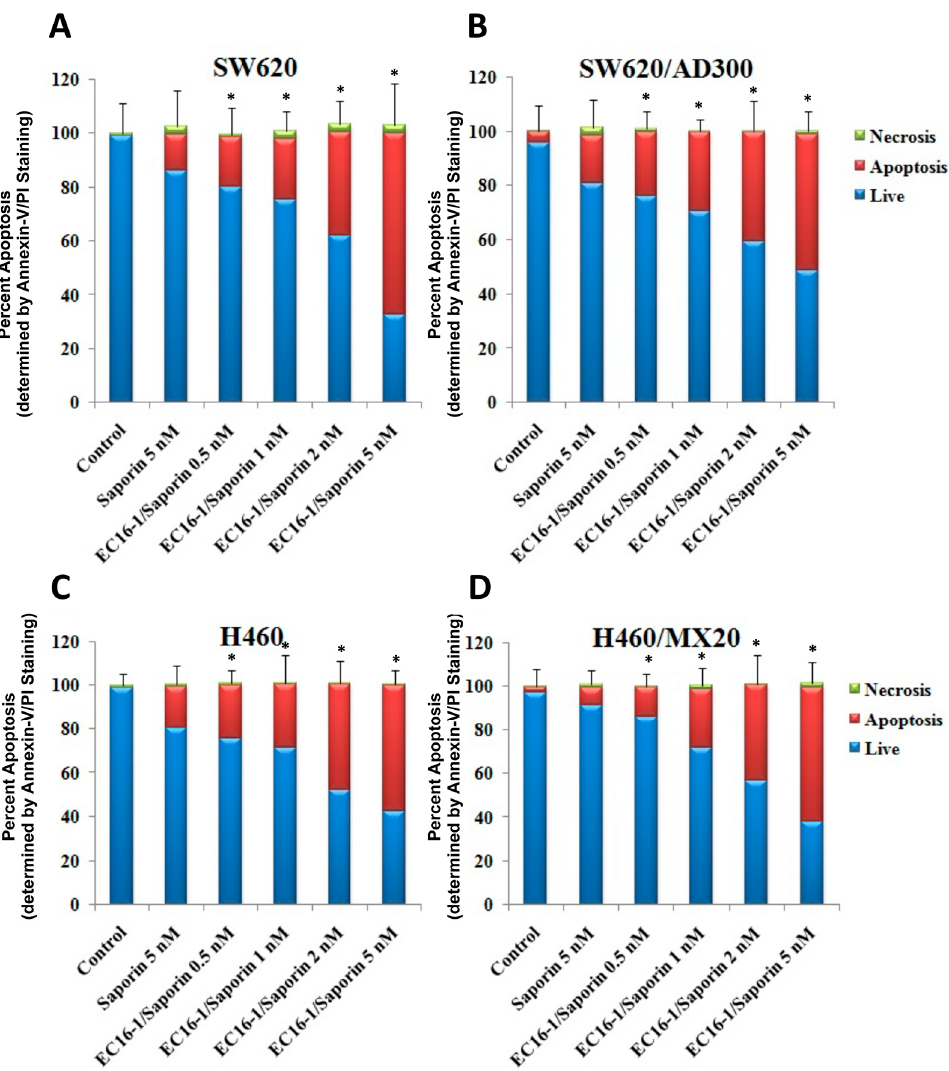
Figure 4. Effect of EC16-1/saporin on the induction of apoptosis in parental and ABCB1- or ABCG2-overexpressing cells. The parental SW620 ( A ) and ABCB1-overexpressing SW620/AD300 ( B ) cells were incubated with saporin (5 nM) or EC16-1/saporin. The parental NCI-H460 ( C ) and ABCG2-overexpressing NCI-H460/MX20 ( D ) cells were incubated with saporin (5 nM) or EC16-1/saporin. The apoptotic cell population was quantified using flow cytometry. The bar graphs represent the average cell population from three independent experiments and the error bars represent the SD. * p < 0.05 compared with control.